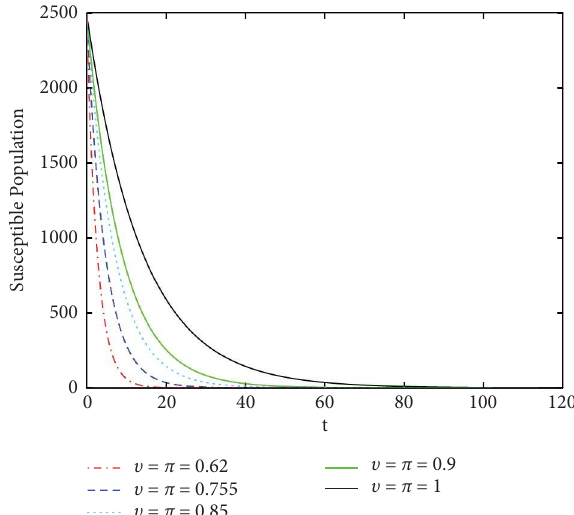
Figure 22: Te dynamics of infected human population for various fractal-fractional orders.